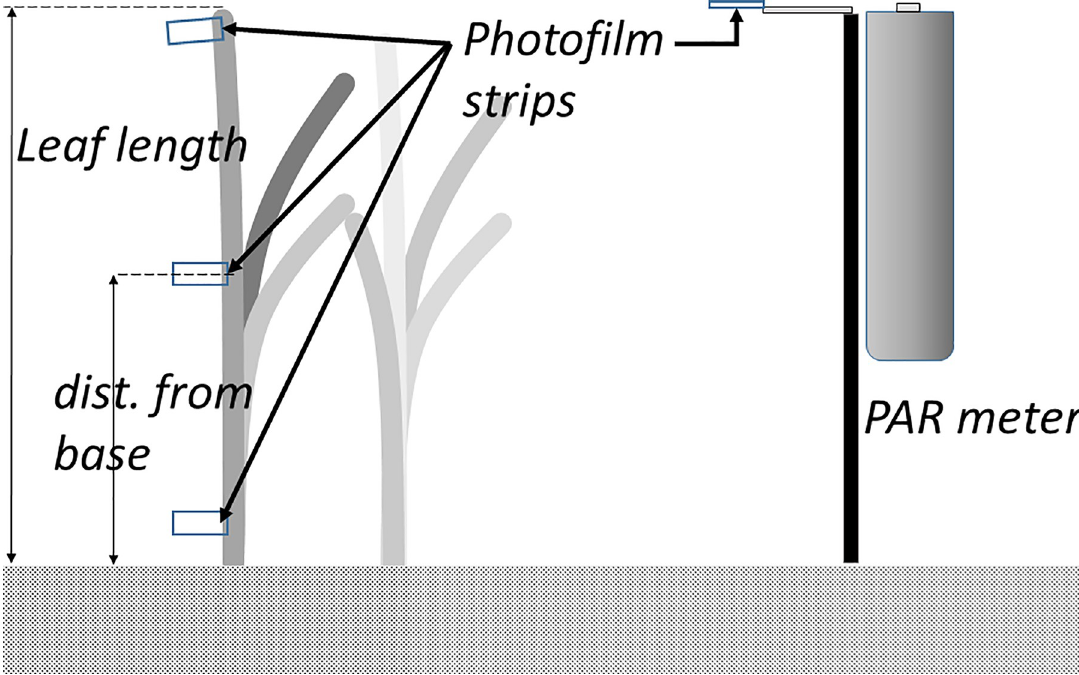
Fig 1. Experimental setup. The photo-filmstrips were attached along the seagrass leaf extending out from the leaf but at the same plane as the leaf surface. On a board attached to the PAR meter, separate filmstrips for calibration were attached horizontally in level with the